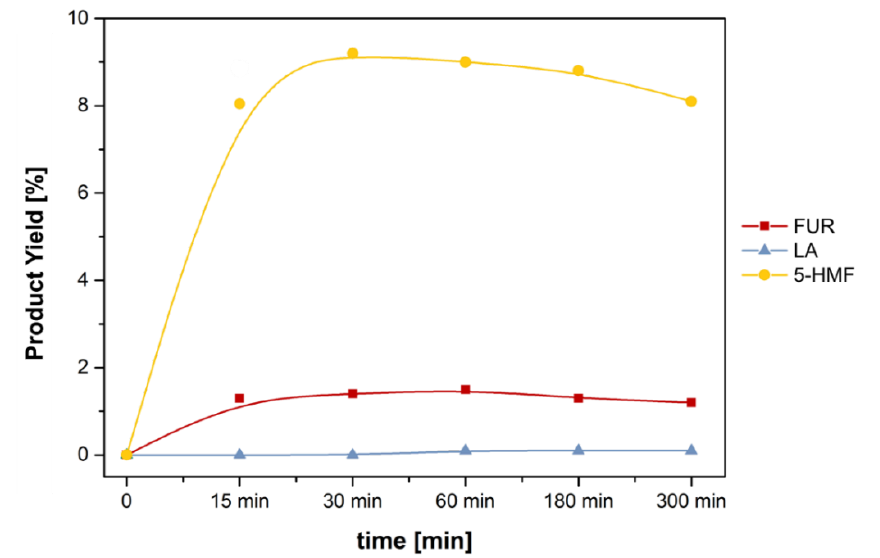
Figure 5. Effect of HTC reaction time on the production of furfural (FU), 5-hydroxymethylfurfural (5-HMF) and levulinic from (LA) OPW under neutral conditions (Reaction conditions: 20 g of OPW; 20 mL of H 2 O; temperature: 180 °C; autogenous pressure; stirring: 600 rpm).